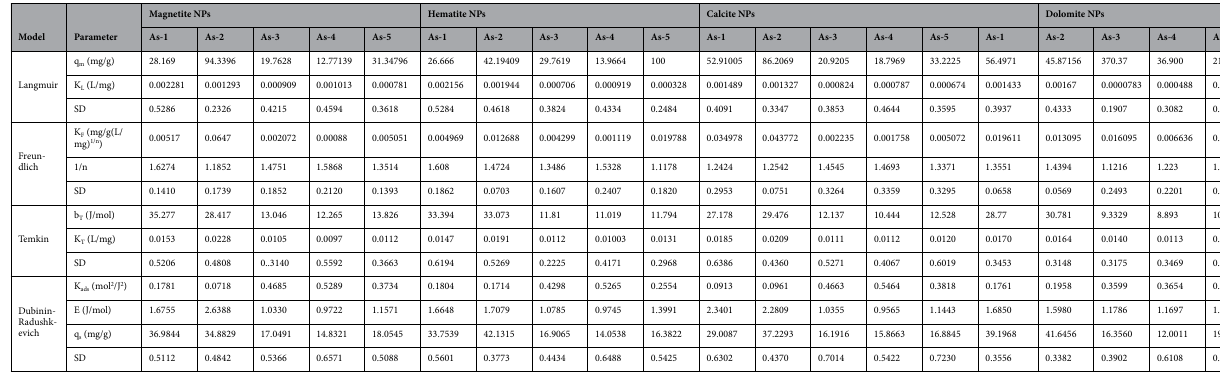
Table 2. Isotherm modeling results for asphaltenes adsorption by iron oxide and lime NPs.